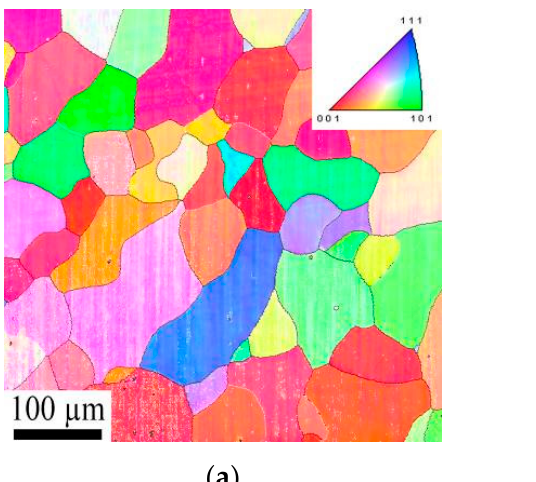
Figure 8. Microstructure of ARMCO iron in the initial state after the fatigue test: ( a ) EBSD IPF map and ( b ) TEM images; the bottom edge of the EBSD map corresponds to the surface of the specimen.